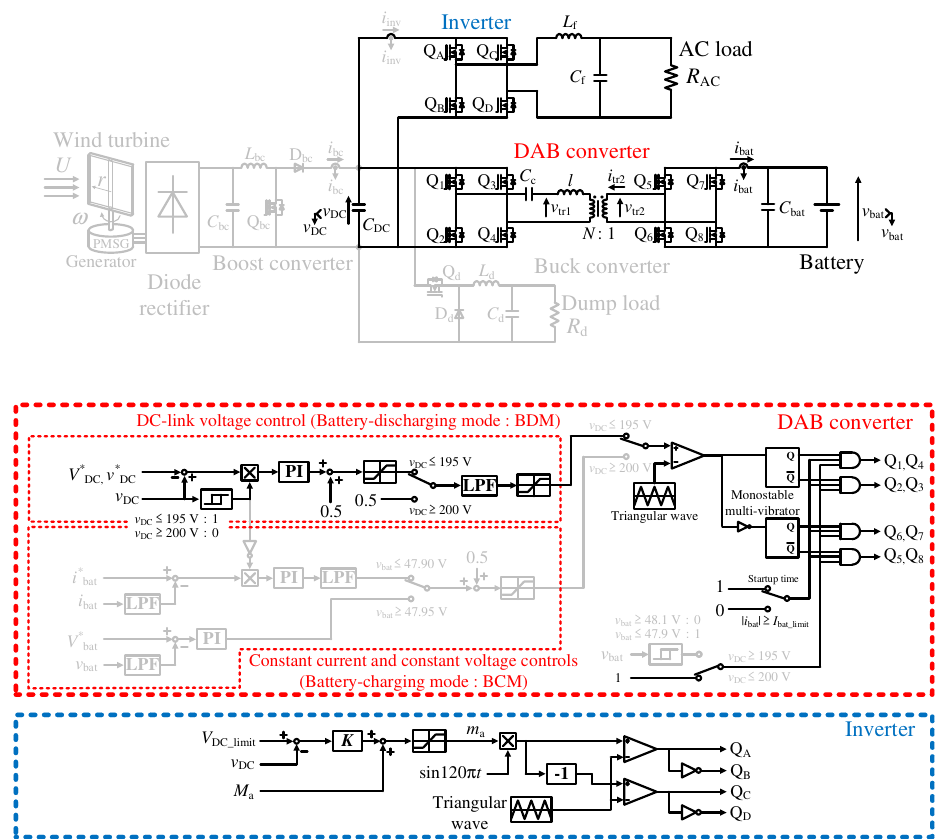
Figure 8. Circuit configuration of DAB converter-based WPGS in battery-discharging mode. Four lead-acid batteries with a nominal voltage of 12.0 V are connected to the sec- ondary side of the DAB converter in series. Discharge cutoff voltage is 40.8 V and fully charged voltage is 48.0 V. Rated power of the DAB converter is designed to be 500 W. The AC load R AC was varied from 200 Ω to 20 Ω so that the transferred power p bat changed from 10% (50 W) to 100% (500 W) of the rated